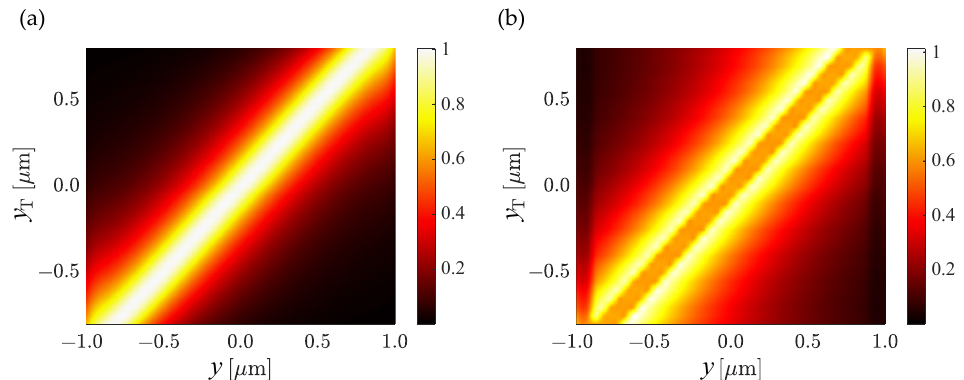
(cid:12) (cid:12) ) along the y -direction as a (cid:12) E y (cid:12) ) along the y -direction as a | 𝐸𝐸 𝑦𝑦 |